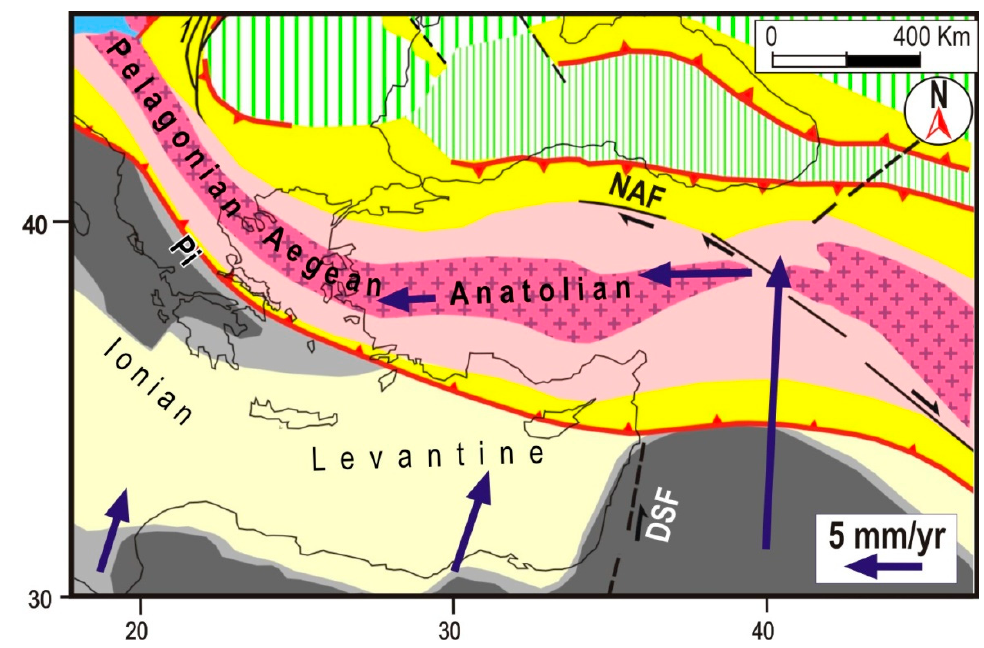
Figure 6. Middle Miocene paleogeographic setting. Present geographical contours (thin black lines) are reported for reference. The kinematics with respect to a Eurasian reference frame [66,67] are tentatively indicated by the blue arrows (scale in the inset). Pi—Pindos zone. Symbols, colors and other abbreviations as in Figure